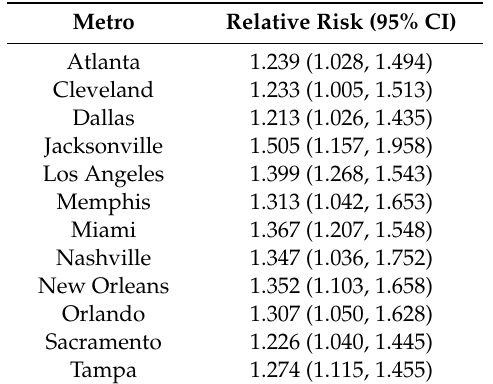
Table 5. Cumulative relative risks for metropolitan areas that have statistically significant increases in mortality during